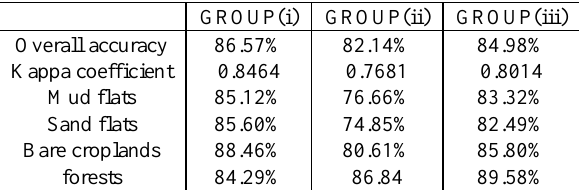
Table 2. Accuracy table of certain classes in each